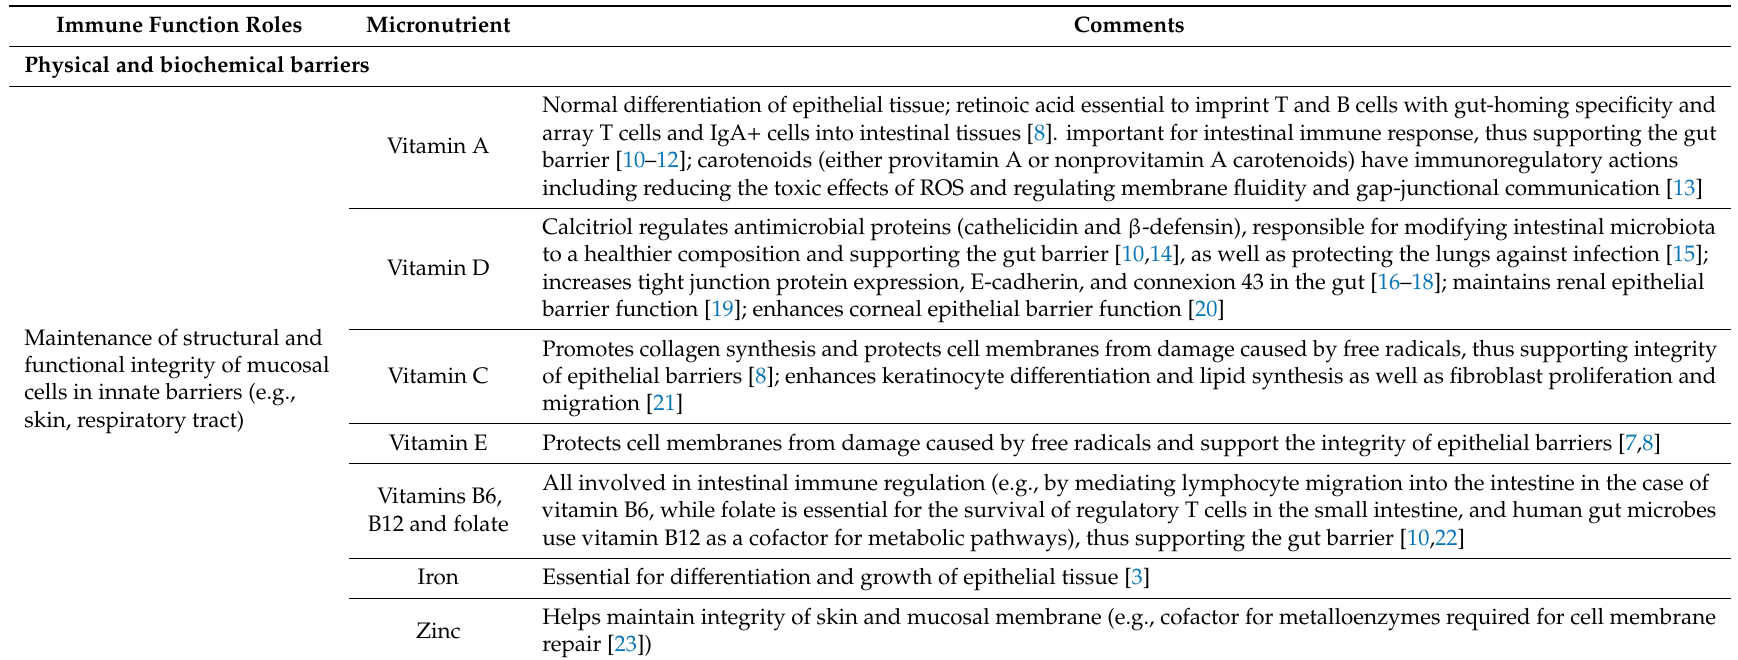
Table 1. Certain micronutrients have key roles in the immune system